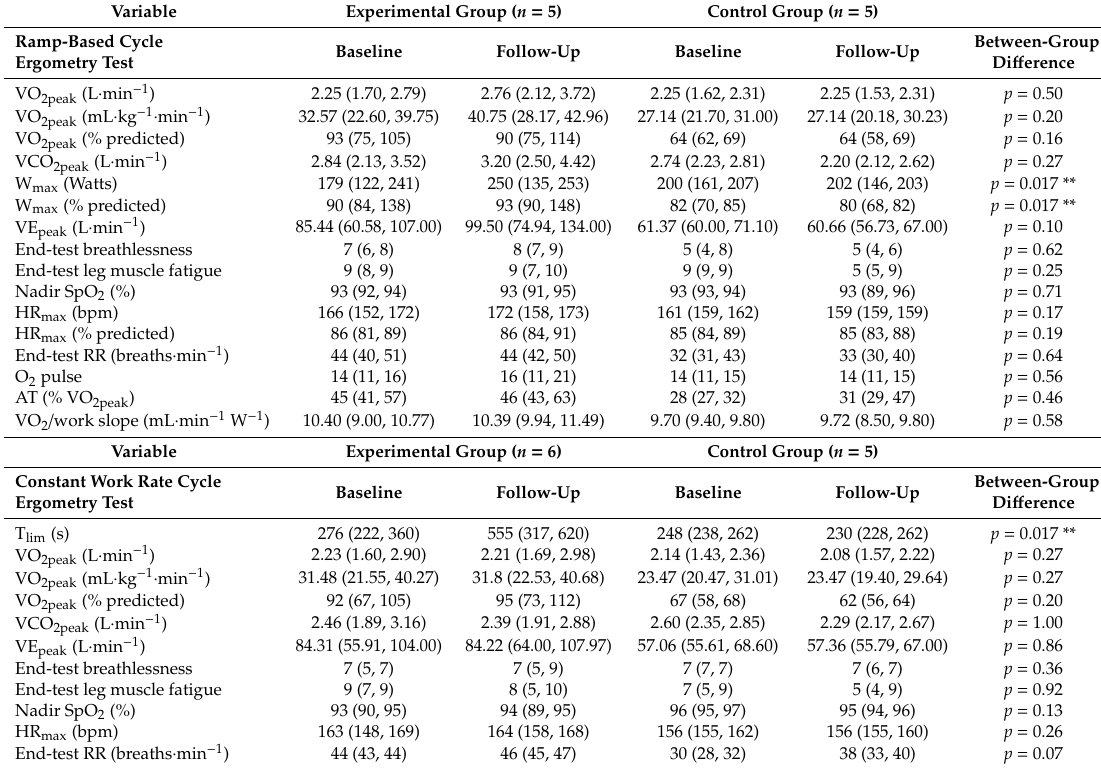
Table 2. Baseline and follow-up measures and comparison of between-group change in exercise capacity. Variable Control Group ( n = 5) Ramp-Based Cycle Ergometry